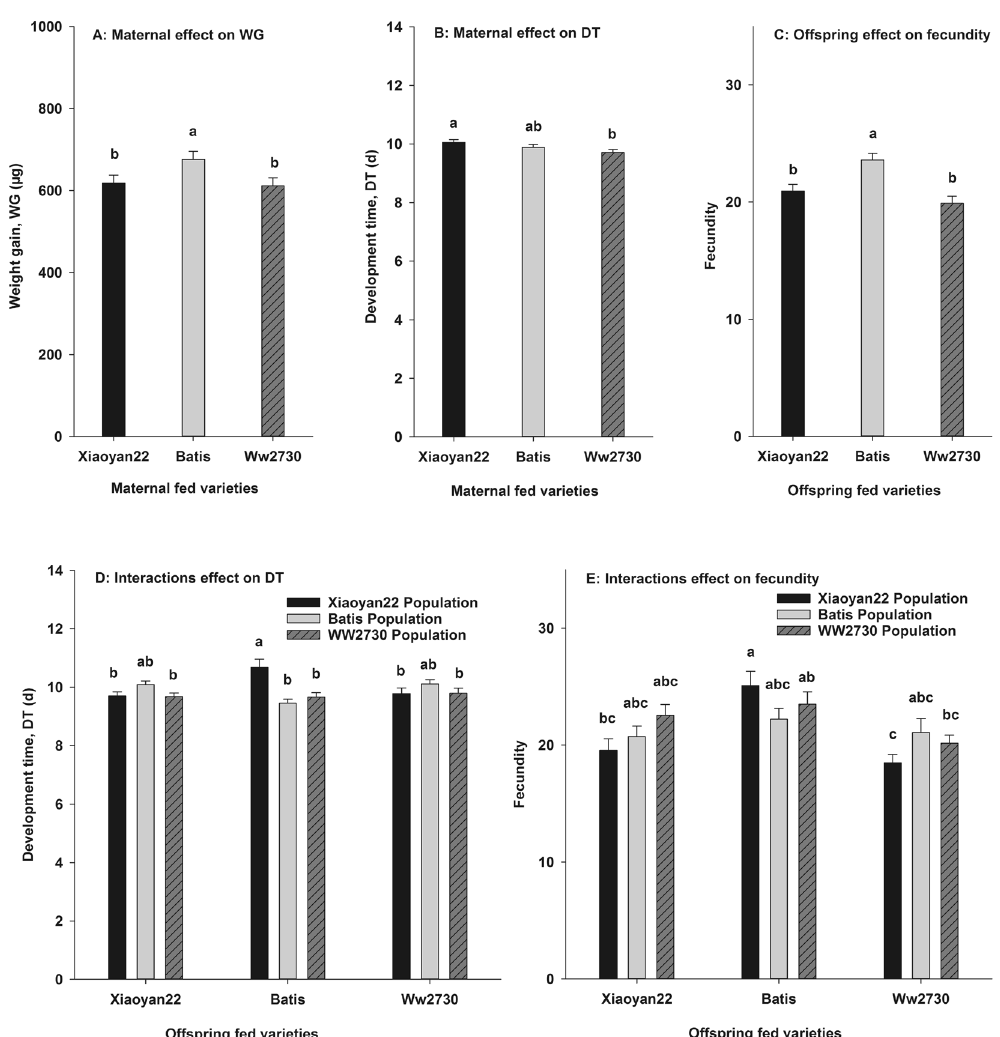
Figure 2. The individual-level hierarchical traits, nymphal survival (NS), development time (DT), weight gain (WG), and fecundity change of Sitobion avenae with host